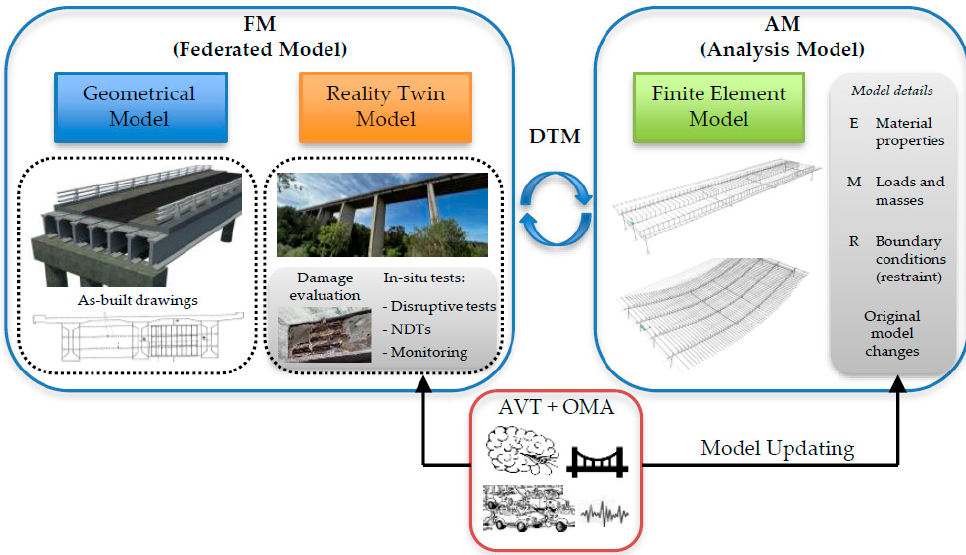
Figure 1. Framework for the development of a DTM for bridges and the role of AVT and OMA.